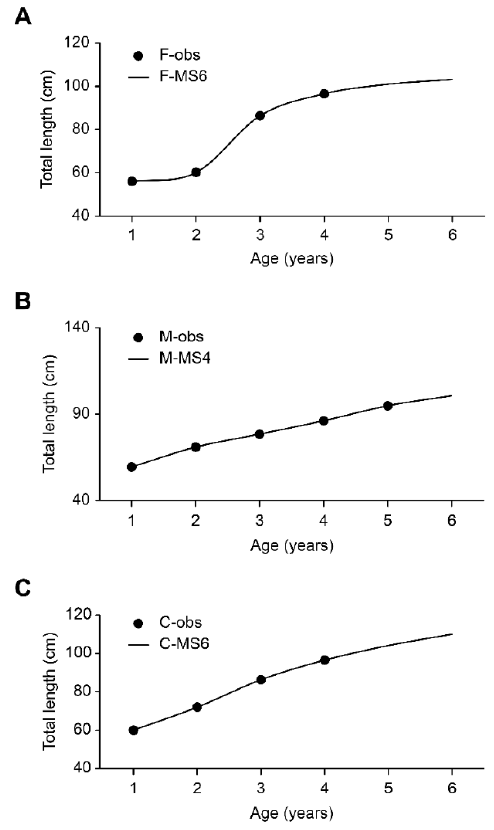
Figure 3. Growth curves of females ( a ), males ( b ), and combined sexes ( c ) of Sphyrna tiburo from the western Gulf of Mexico. Dark filled circles are the observed values, and the lines are the estimated values. F − obs = observed values for females; F − S6 = model selected for females; M − obs = observed values for males; M − S6 = model selected for males; C − obs = observed values for combined sexes; and C − S6 = model selected for combined sexes. Table 4. Number of parameters ( Φ ) and values of the parameters estimated per model for females, males, and both sexes combined for the bonnethead shark ( Sphyrna tiburo ) in the western Gulf of Mexico.